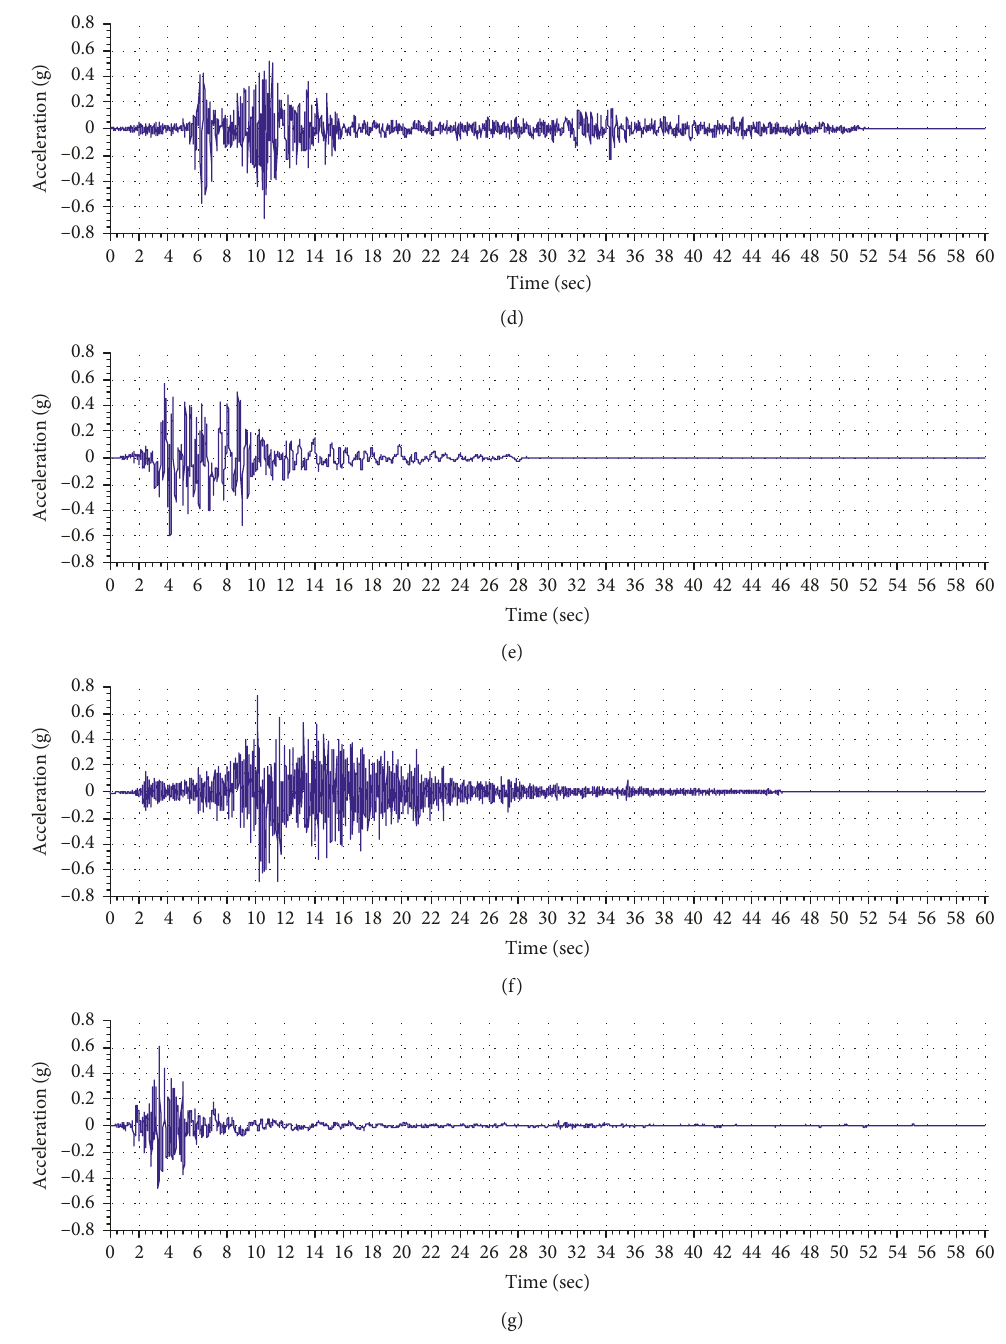
Figure 8: Earthquake acceleration records obtained from Pacific Earthquake Engineering Research Center (PEER) [31]. (a) Bam, Iran, 2003. (b) El Centro, USA, 1940. (c) Kobe, Japan, 1995. (d) Manjil, Iran, 2002. (e) Northridge, USA, 1971. (f) Landers, USA, 1992. (g) San Fernando, USA, 1994. Table 2: Parameters of the design response